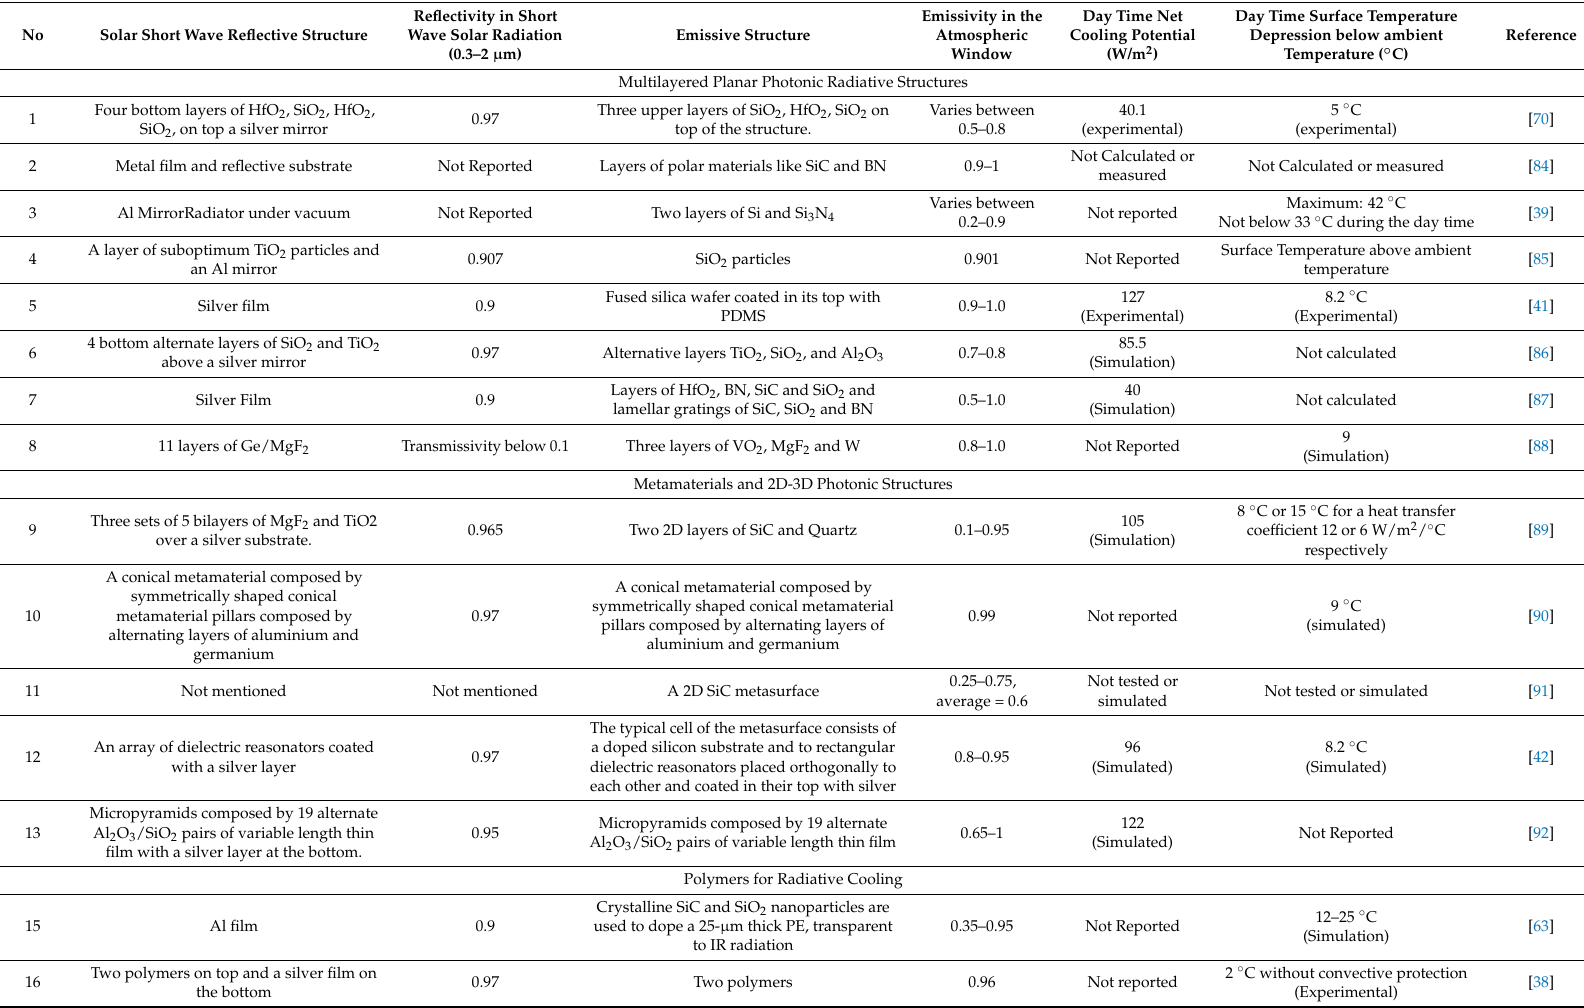
Table 1. The main daytime radiative cooling technologies and structures, their composition, optical characteristics and